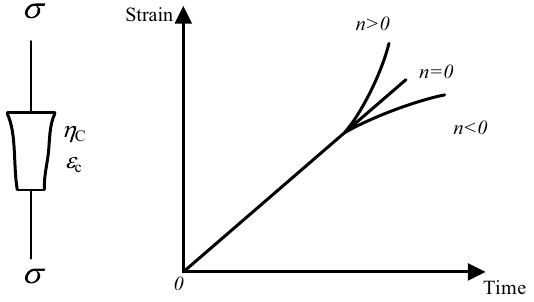
Figure 4. Nonlinear Newton body and creep